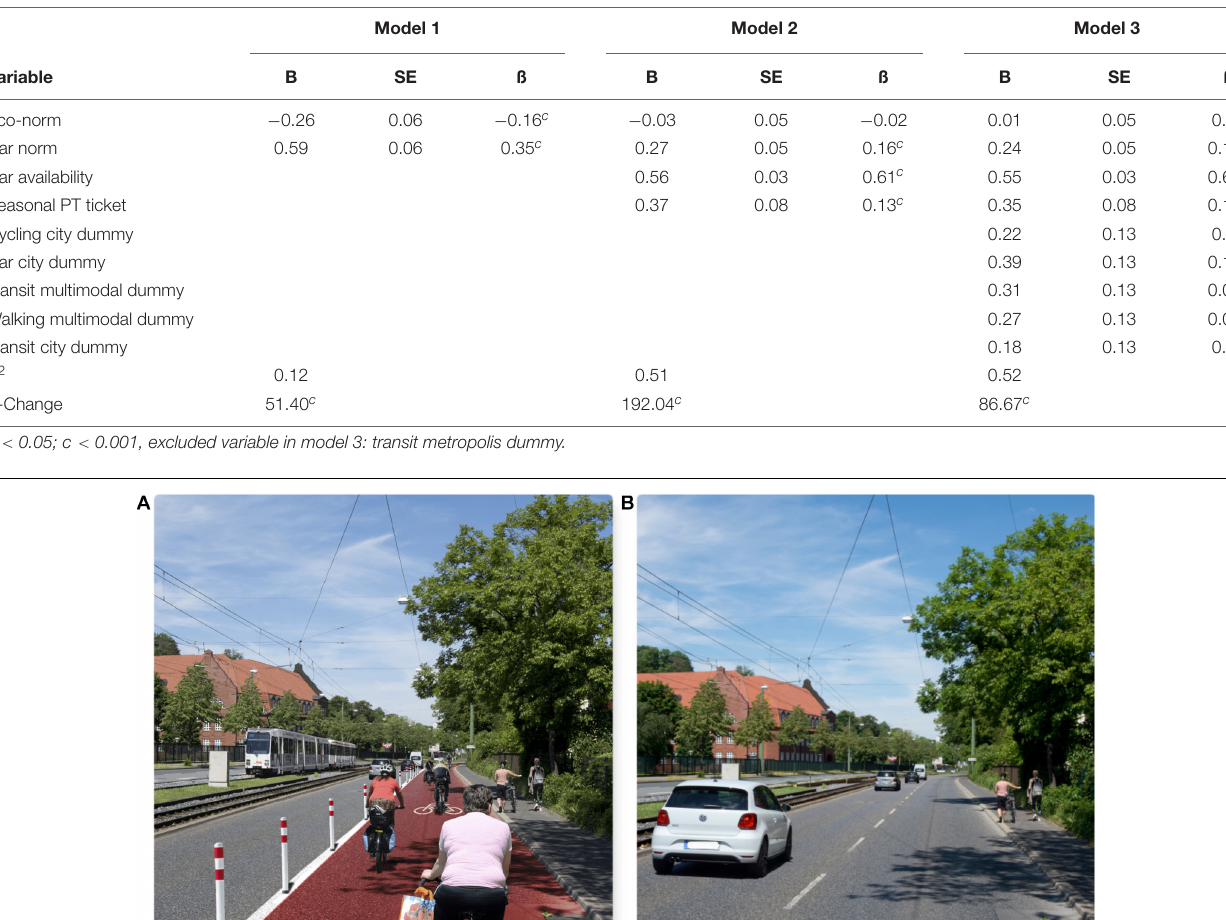
TABLE 2 | (Study 1) Comparing the predictive power of “eco-norm” vs. “car-norm,” car availability and seasonal ticket for PT on self-reported car use and dummy variables of the city types (Study 1, regression analysis, N = 725). Explained variable: self-reported own car use